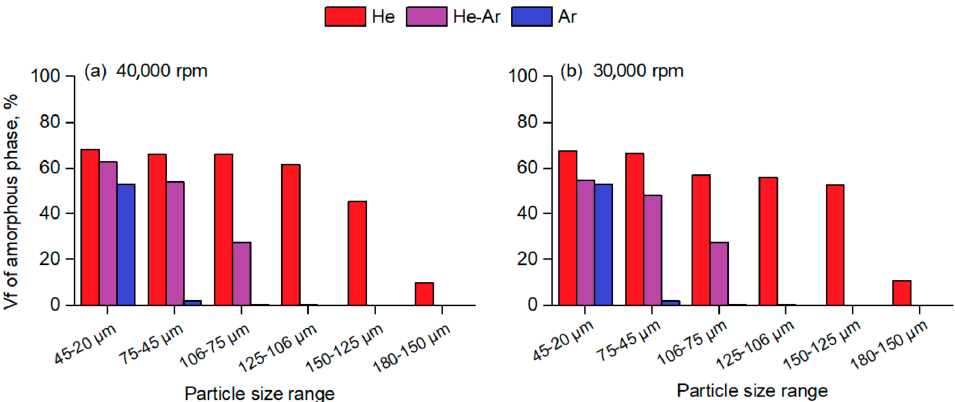
Figure 6. Amorphous volume fraction of the centrifugally atomized Al 86 Ni 8 Y 4.5 La 1.5 powder as a function of the corresponding particle size range using different gas compositions: ( a ) particles atomized at a disk speed of 40,000 rpm; ( b ) particles atomized at a disk speed of 30,000 rpm.